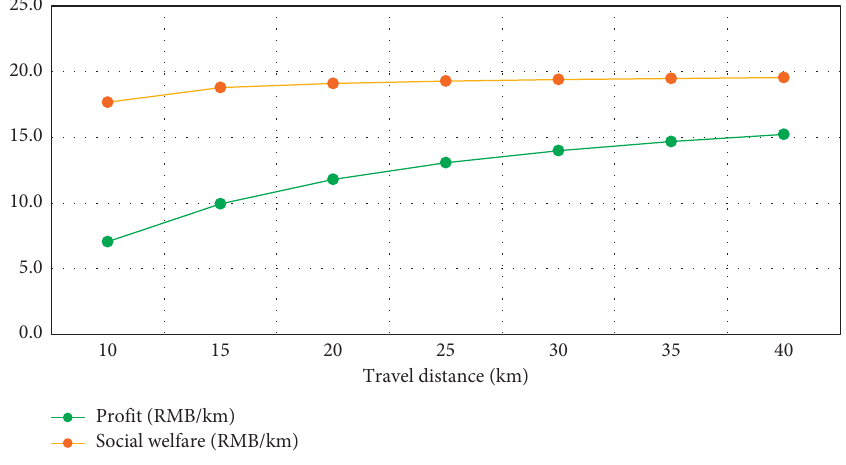
Figure 9: Effects of the travel distance (Case 1).